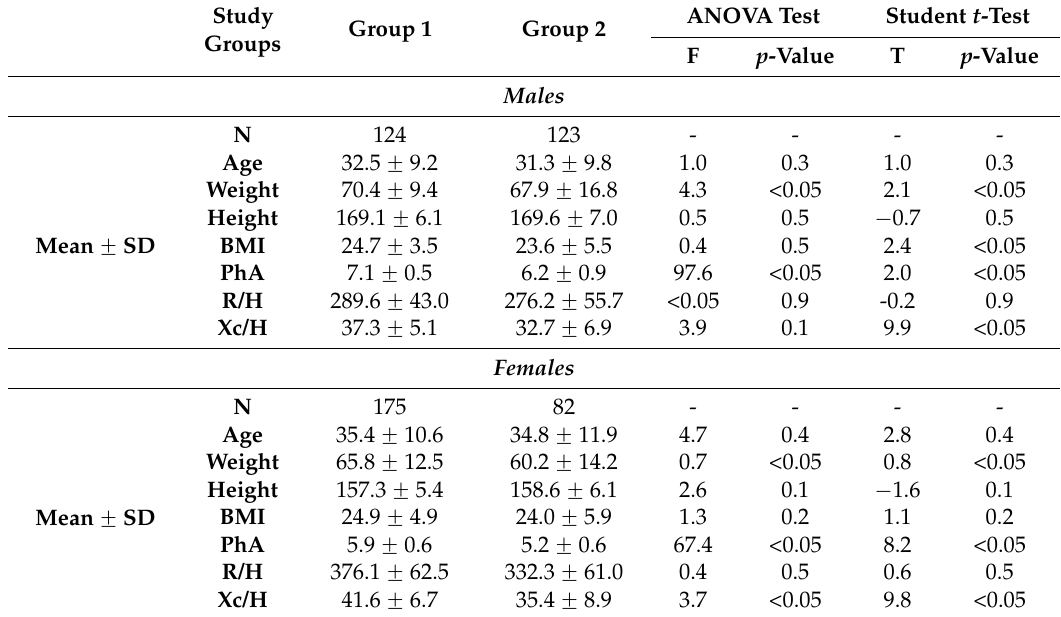
Table 1. Demographic and BIVA parameters for healthy (Group 1) and Dengue-infected subjects (Group